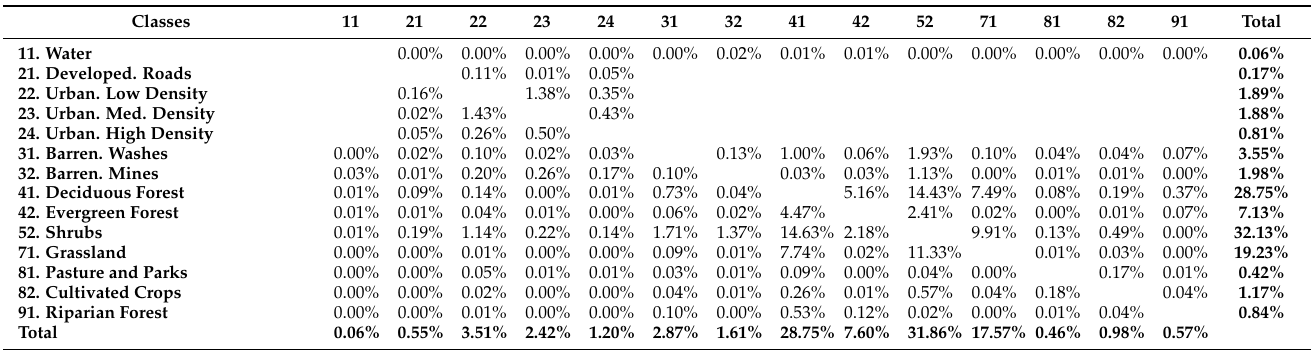
Table 3. 1986–2020 cumulative yearly identified changes matrix (initial land cover in lines, final land cover in columns, values are percentages of all detected changes totaling 27,318,648 pixel